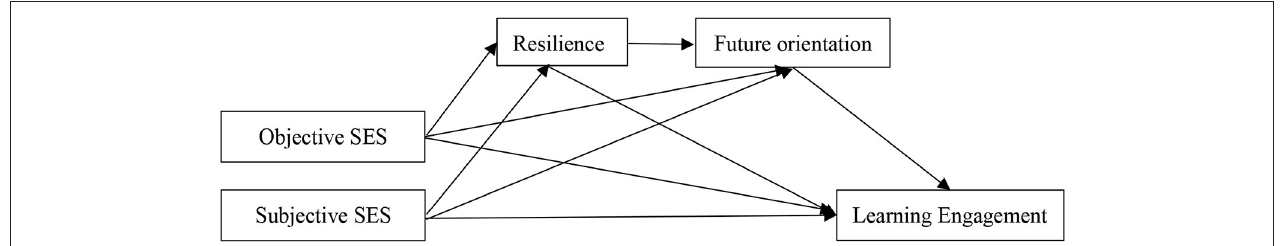
FIGURE 1 | Conceptual model. SES, socioeconomic